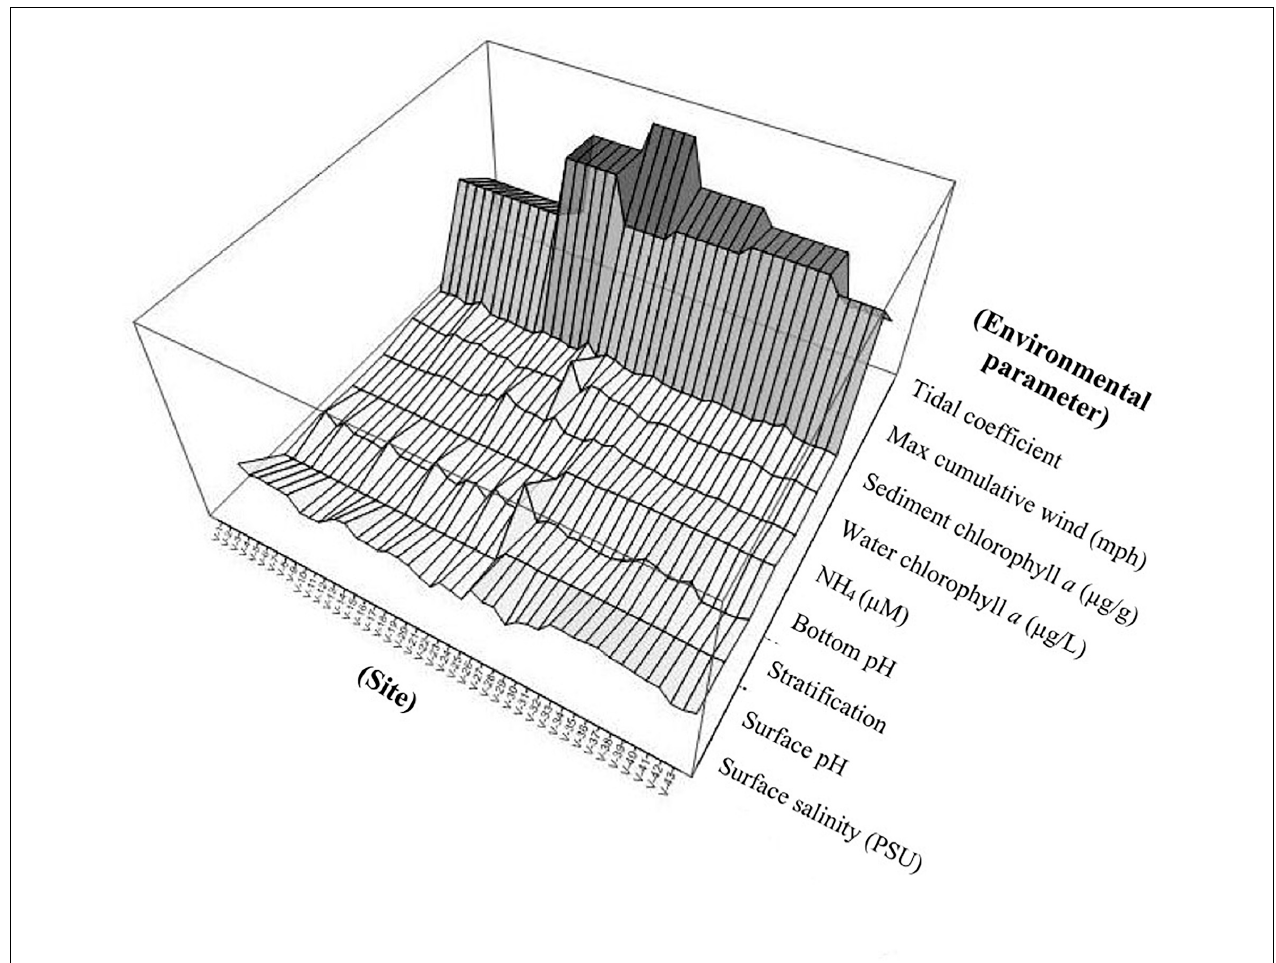
FIGURE 5 | Surface plot illustrating site-to-site variation of the most influential environmental parameters covarying with Vibrio abundances.